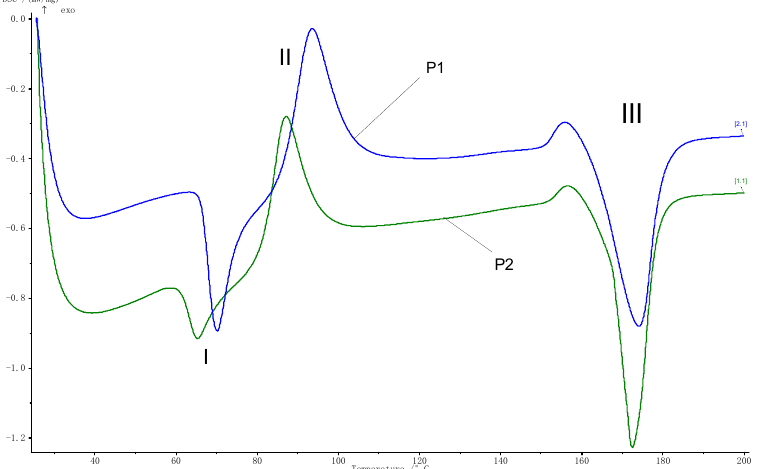
Figure 6. Highlighting the thermal behaviors of the tested samples: I, the first transformation; II, the second transformation; III, the third transformation; P1 (blue) and P2 (green) curves.